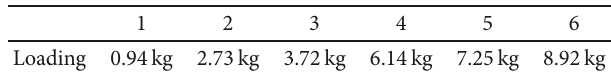
Figure 6: (a) Loading on end-node of entire structure. (b) NDI Optotrak Certus. (c) Position sensors and FBG sensors. Table 4: Static loading